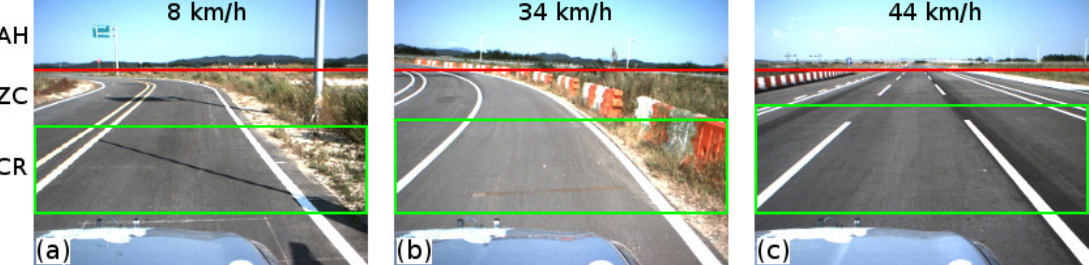
Figure 3. Road region of interest estimation, based on the speed of the vehicle. ( a – c ) show the region of the interest at various speed of the vehicle. The red line shows the region above the horizon (AH). The green square shows the region of interest, which depends on the vehicle speed. This is defined as collision risk region (CR). The region between the AH and the CR is defined as the zero collision risk region